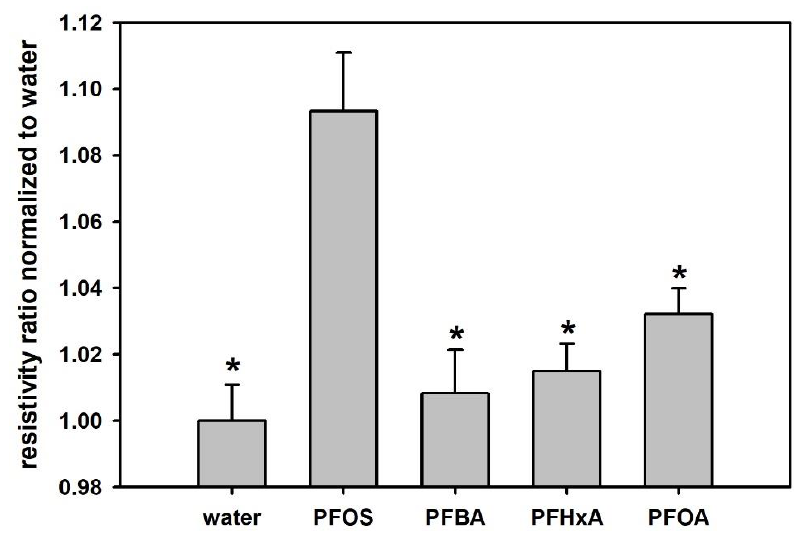
Figure 6. The selectivity of PFOS-MIP-PANI to PFOS, PFBA, PFHxA, and PFOA. The concentration for each chemical in the aqueous samples was 70 ppt. The data were normalized to water resistivity. Each bar denotes the average of DC resistivity ratios measured from three devices, and the standard deviations are also calculated and marked as the error bars. The asterisks represent significance ( p < 0.05) lower than the response of PFOS.